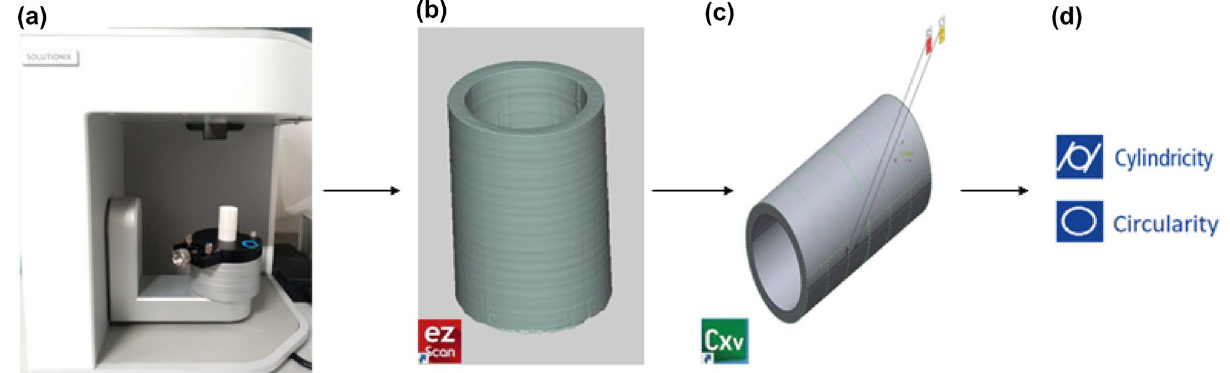
Figure 3. Schematic of scanning process to find the cylindricity and circularity error. ( a ) Scaning the parts by Solutionx D500, ( b ) Solutionx Ezscan software, ( c ) Geomagic Control X, ( d ) Measuring the geometrical